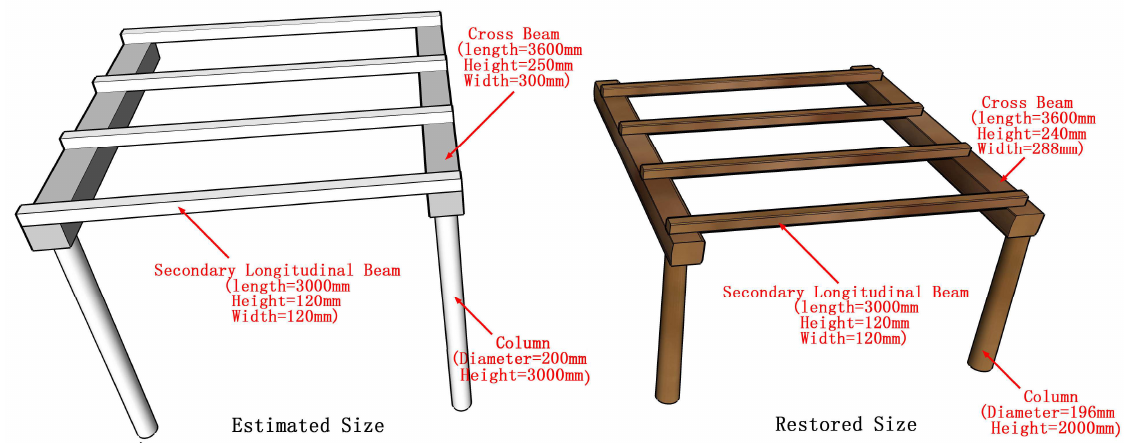
Figure 11. Compare the estimated size with the restored size of plank